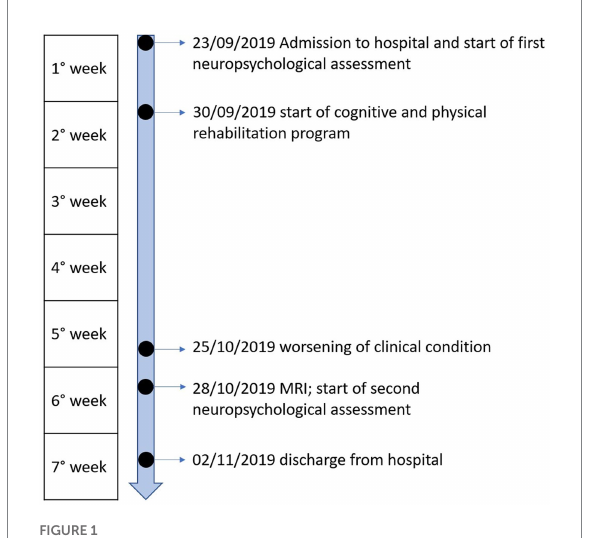
FIGURE 1 Timeline of events of the case